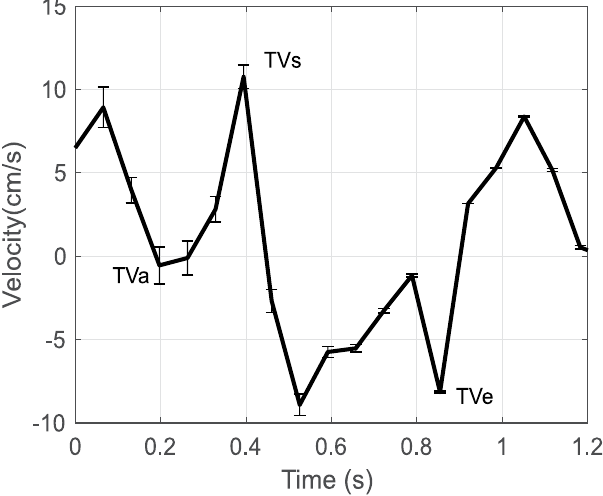
Figure 7. Tissue velocity calculated using DIC and the standard deviation error bars for each